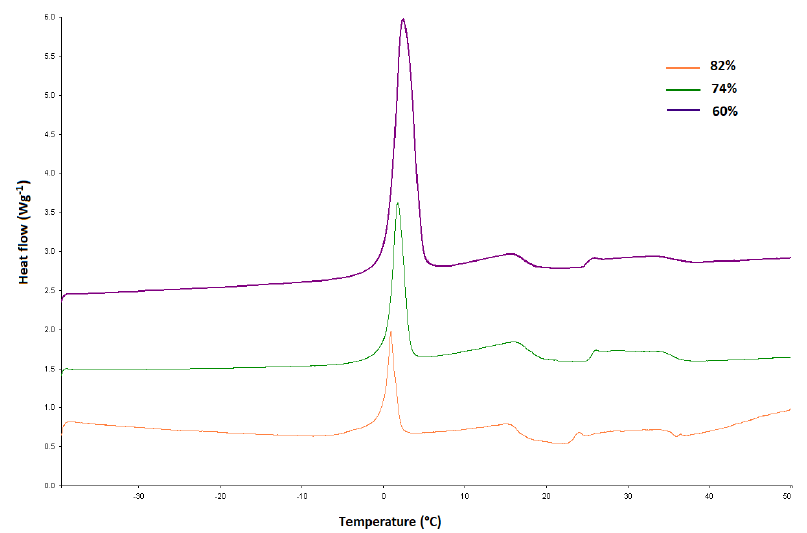
Figure 1. DSC melting curves of three types of milk fat products with fat contents of 60%, 74% and 82%.